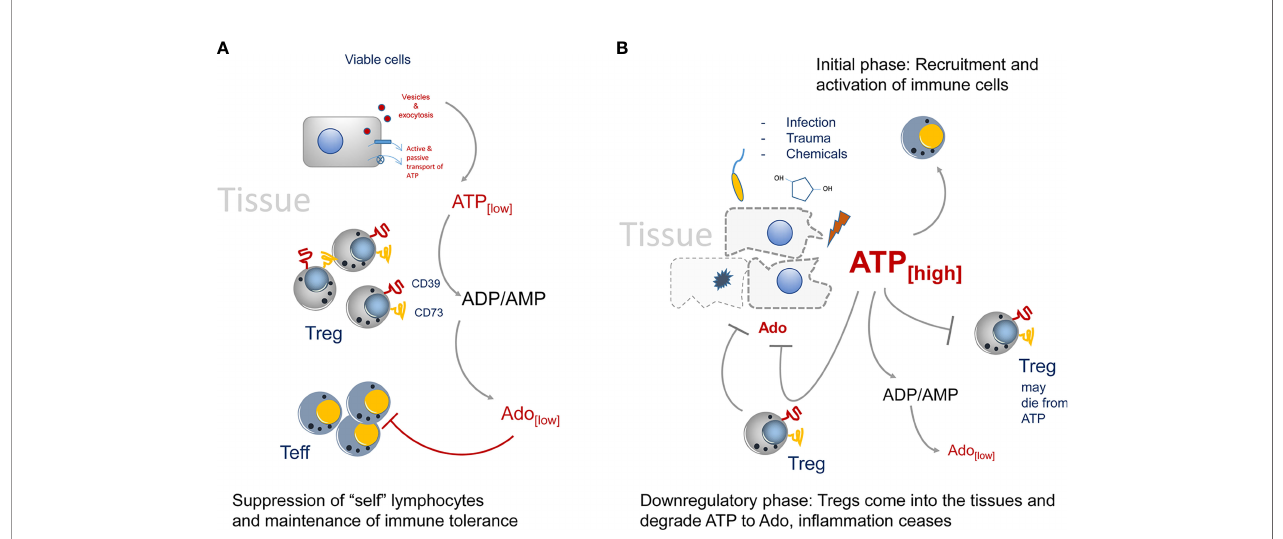
FIGURE 1 | Regulation of CD73-mediated adenosine production in healthy and diseased tissues. (A) In the steady state only trace amounts of ATP are released by viable or by dying cells. It will be immediately degraded by CD73 to adenosine. Adenosine acts as immune suppressor and maintains immune tolerance by creating an immune suppressive environment. (B) The situation changes when infection, trauma and toxicity occur. Massive release of ATP cannot be degraded immediately by CD73. It activates lymphocytes and downregulates Treg populations, presumably by inducing cell death. Adenosine concentrations are kept low to maintain immunity. Later, more Tregs will enter the tissue side, degrading ATP and producing the immune suppressor